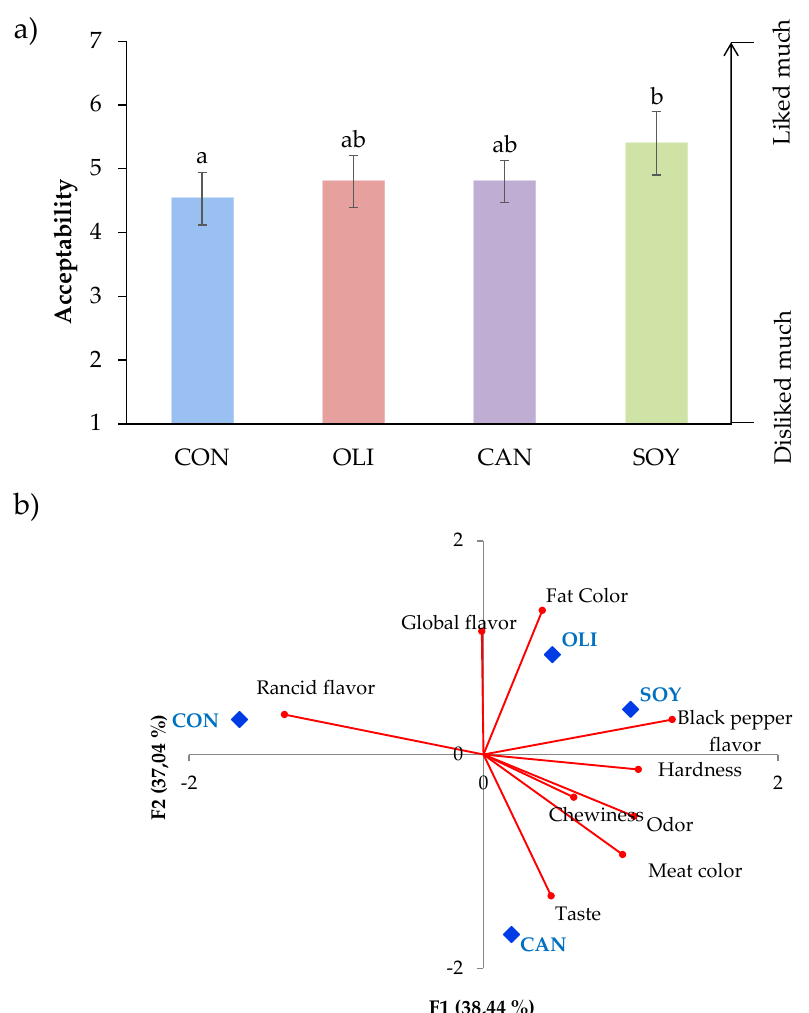
Figure 2. Global acceptance of dry-fermented deer sausages reformulated with healthy oils ( A ) and projection of the sensory attributes and sample batch in the plane defined by the first two components ( B ). a – b The bars of the figure 2A with different letter differ significantly ( p < 0.05; Duncan test).